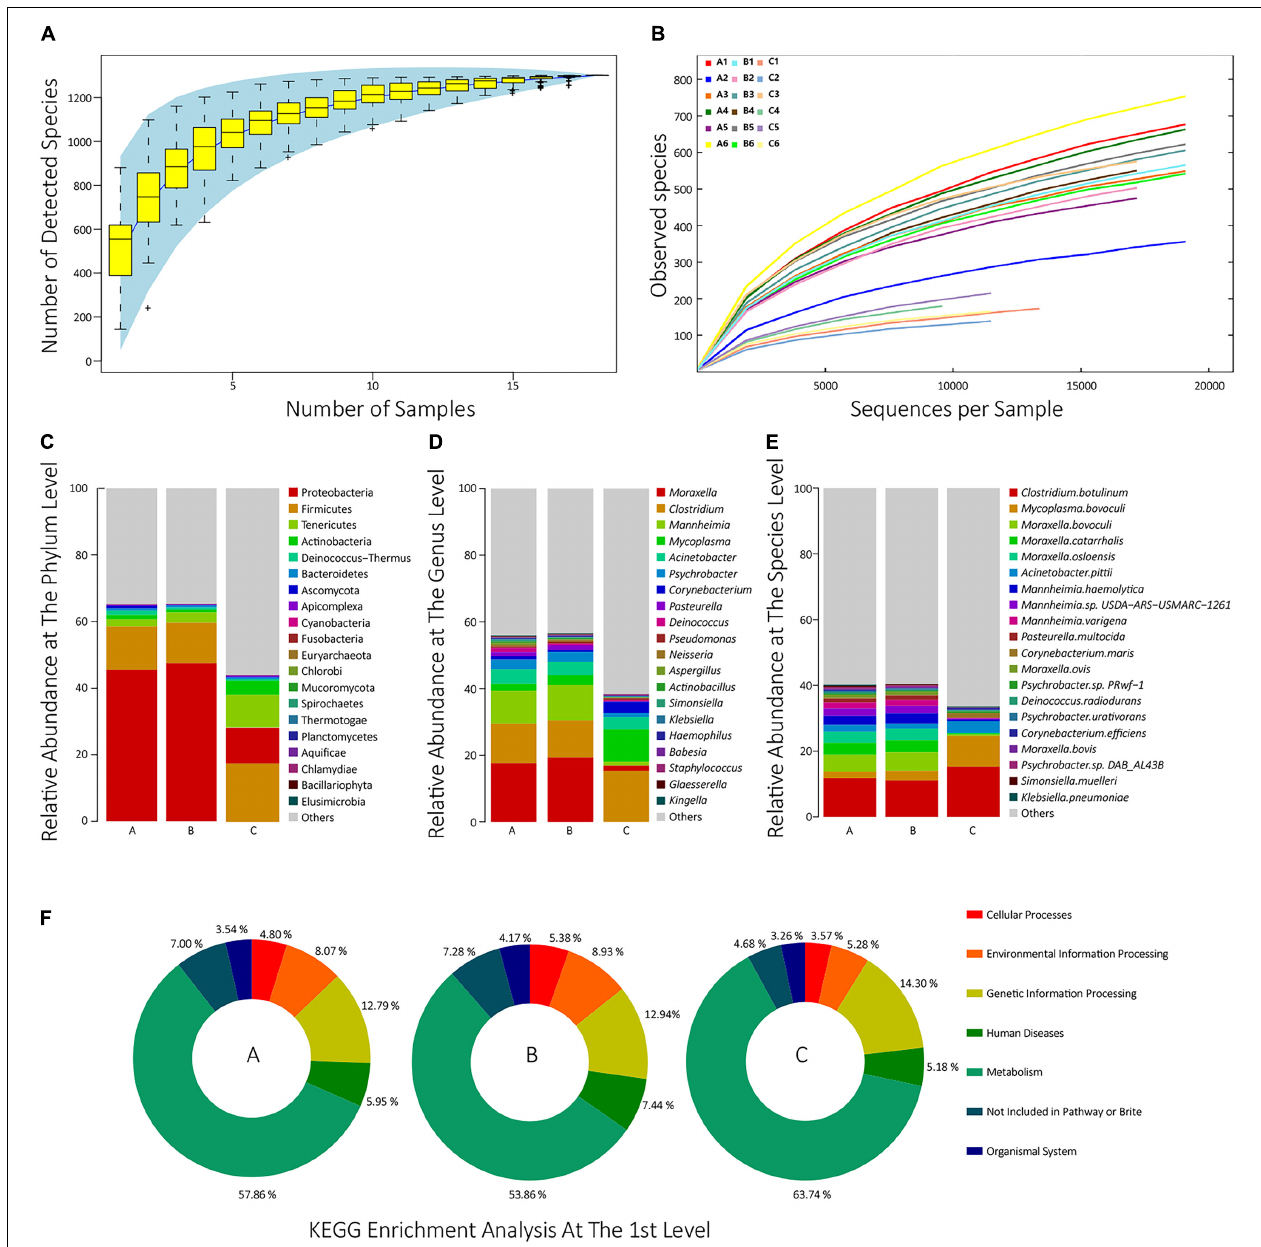
FIGURE 1 | (A) The Specaccum species accumulation curve at the species level. The horizontal axis represents the sequencing sample size; the longitudinal axis represents the detected species number at the species level; the blue shadow reflects the curve’s confidence interval; the slope of the curve represents the rate of newly discovered species with expanding samples size. (B) Rarefaction curves at the species level of all samples. The horizontal axis represents the number of randomly selected sequences; the longitudinal axis represents the number of detected species in a sequencing depth; the length of the curves represents sequencing depth. If the curve is longer, the sequencing is more deep, and the possibility of detecting new species is higher; the slope of the curve represents the strength of the effect of sample size on the sequencing result, and if the curve is gentler, the sequencing result is more credible for reflecting the composition of the sample. (C–E) The top 20 taxon composition with the highest relative abundance of each group at the phylum, genus, and species level, respectively. (F) The relative abundances of the first KEGG pathways for each